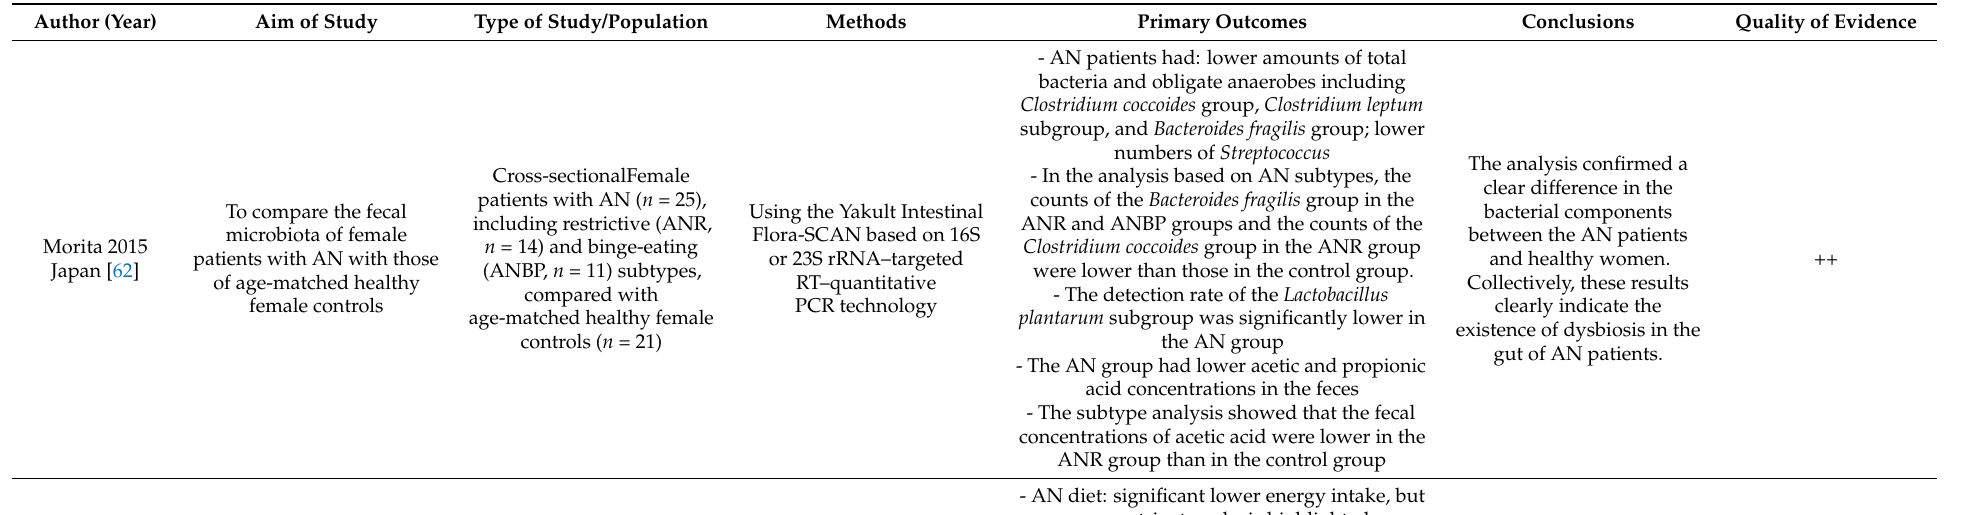
Table 1. Recent studies focused on the role of microbiota in anorexia